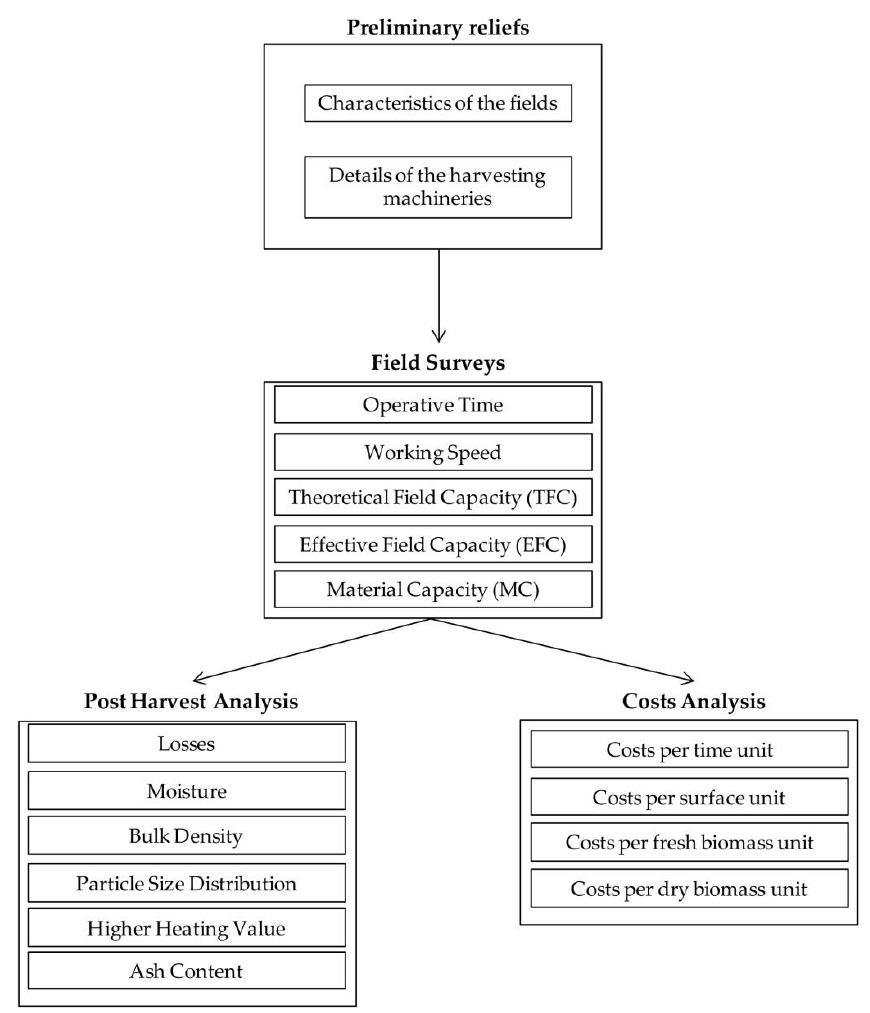
Figure 1. Graphical block diagram of the research procedure.